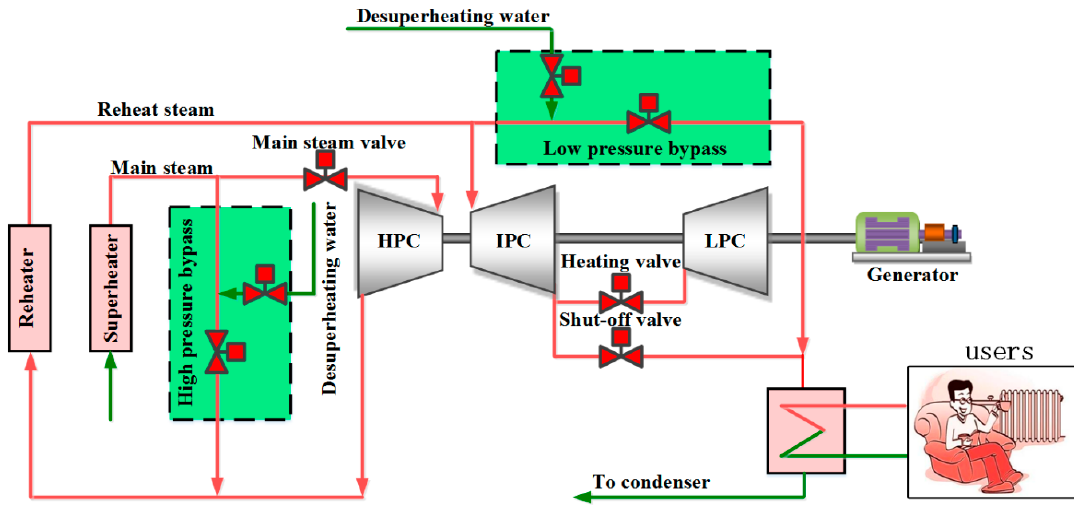
Figure 1. Schematic of a combined heat and power (CHP) unit with two-stage bypass.